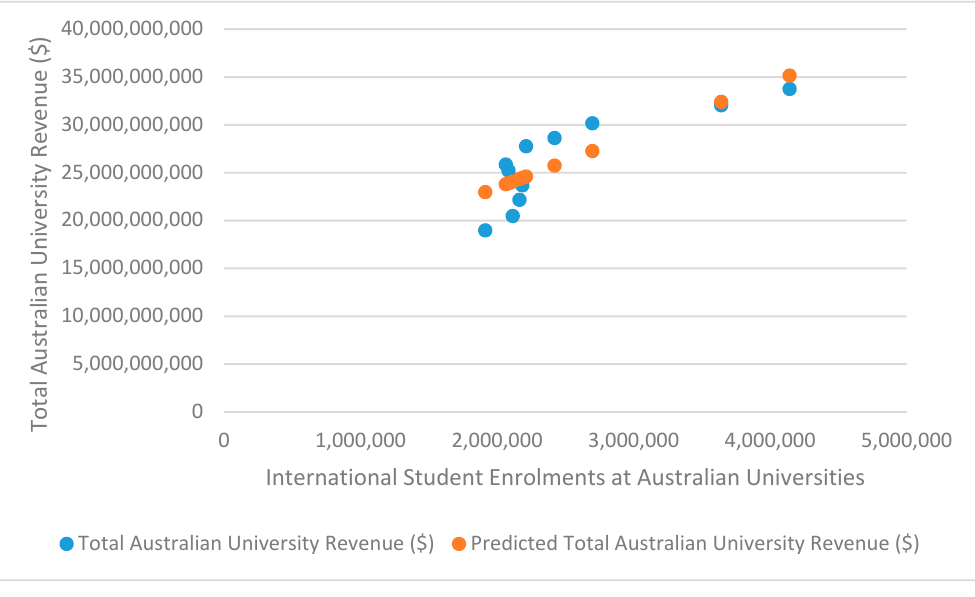
Figure 4. Line Fit Plot for International Student Enrolments and Total Australian University Revenue.